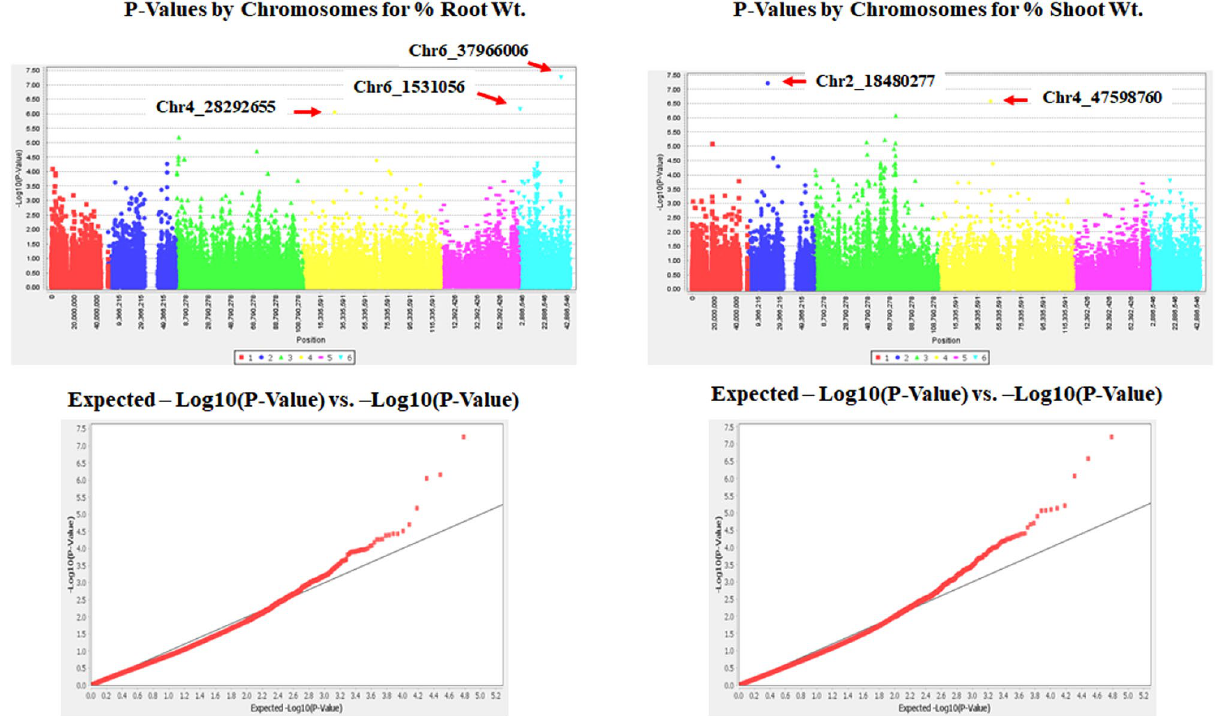
Figure 4. Distributions of Manhattan and QQ-plots of GWAS based on MLM for % root and shoot weights, where the x-axis represents the spinach chromosomes and the y-axis represents LOD [–log(P-value)] value of each SNP in Manhattan plot, and x-axis represents the Expected LOD [–log( P -value)] (shown in red color), and the y-axis represents Observed LOD [–log( P -value)] (shown as black line) value of each SNP in